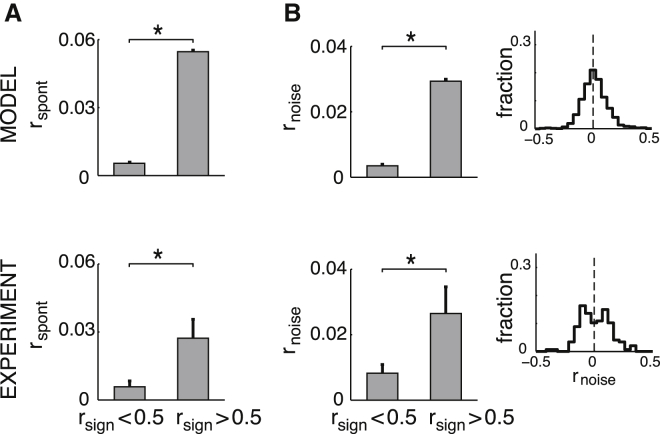
Relationship between Signal, Noise, and Spontaneous Correlations(A) Dependence of correlations during spontaneous activity, rspont, on spike-count signal correlations, rsign.(B) Dependence of noise correlations during evoked activity, rnoise, on signal correlations. Bars show averages across cell pairs with signal correlations below or above the rsign = 0.5 threshold, as shown on the x axis; error bars show SE, ∗p < 0.05. Insets show the distribution of noise correlations; dashed line shows the mean of the distribution. Bottom panels present analyses of data from Ecker et al. (2010) (extracellular unit recordings in awake macaque).